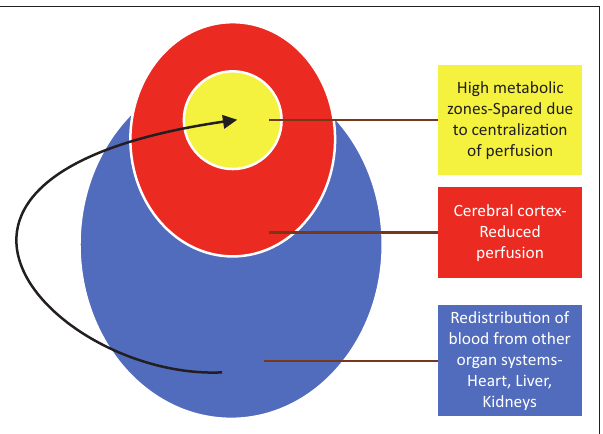
FIGURE 13: Diagrammatic representation of the redistribution of blood away from the visceral organ systems and cerebral cortex in favour of the most important central brain structures.